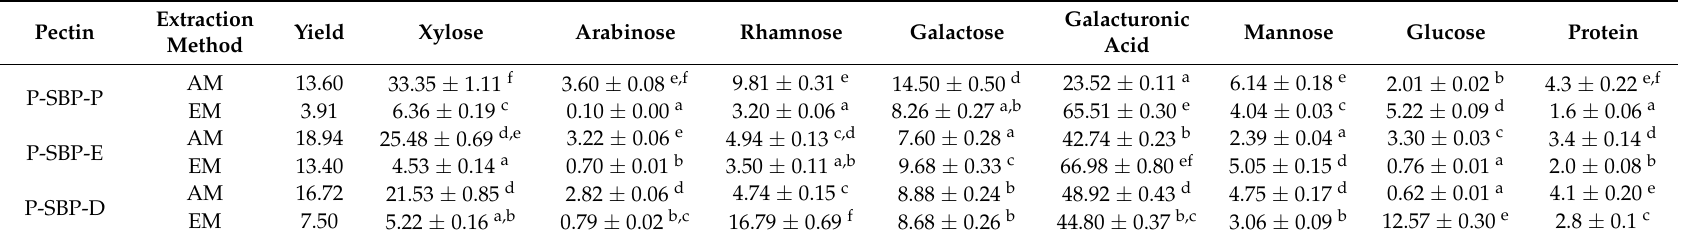
Table 2. Yield extraction (g pectin/100 g DW), monomeric composition and protein of pectin from sugar beet by-products (g/100 g DW). Extraction Pectin Yield Xylose Arabinose Rhamnose Galactose Method